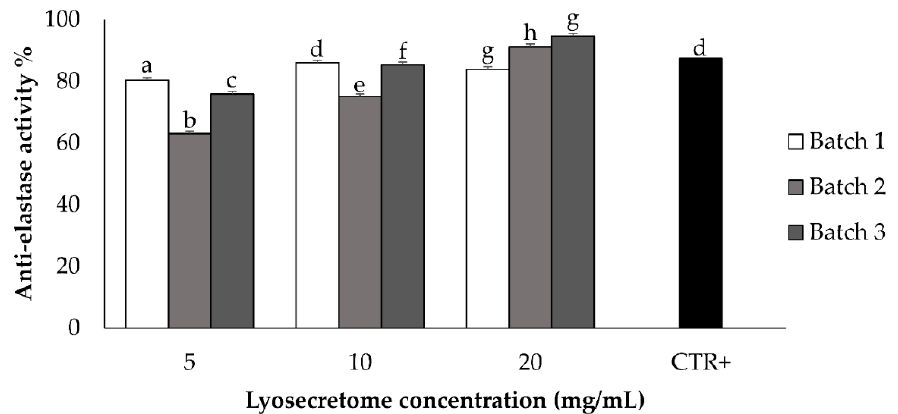
Figure 3. The anti-elastase activity was tested for the three batches at the concentrations of 2, 5, 10 and 20 mg/mL of Lyosecretome. A dose-dependent trend was obtained. CTR + was epigallocatechin gallate at a concentration of 7.2 mg/mL in deionized water. Multifactor ANOVA, mean values ± LSD ( n = 3). Different letters (a–h) indicate a significant difference between the means ( p < 0.05), while the same letters indicate no significant differences ( p > 0.05).